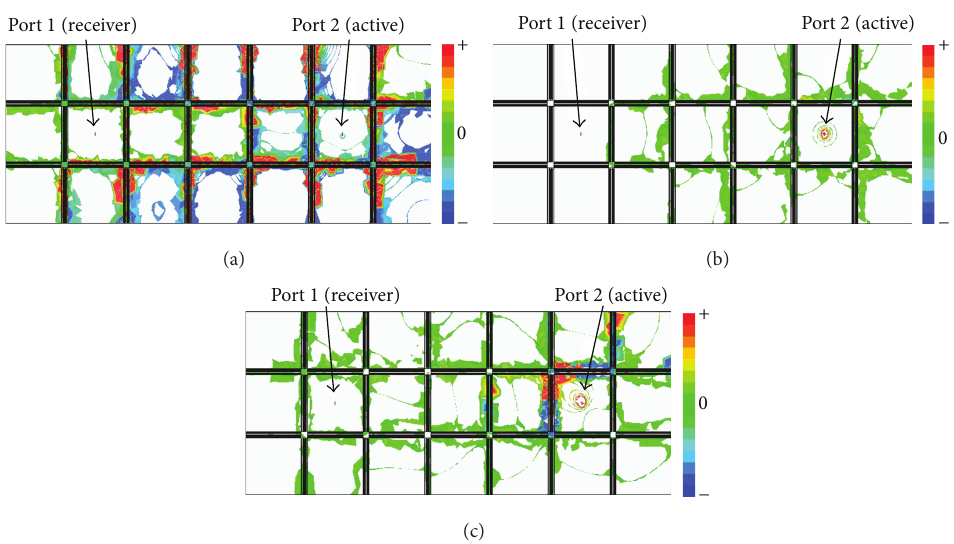
Figure 13: Reactive power density per volume stored inside the EBG-patterned parallel-plane setup: (a) at 2GHz, (b) at 3.5 GHz, and (c) at 4.5 GHz. The color scale map shows the positive and negative range of power.